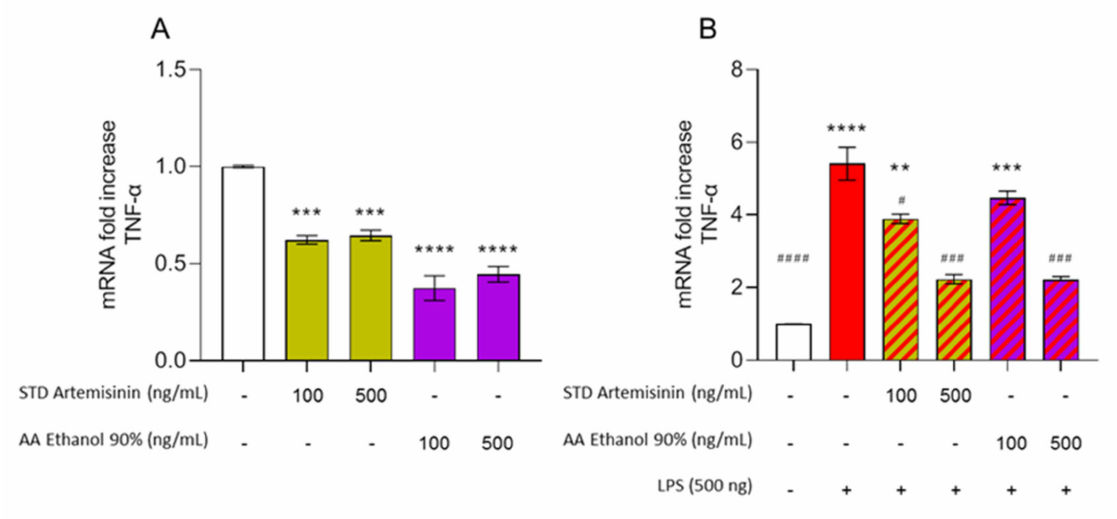
Figure 8. Ethanolic extracts of Artemisia annua and ART are able to act as a TNF- α inhibitor in the presence or absence of LPS. SH-SY5Y cells were treated for 24 h with STD Artemisinin and AA Ethanol 90% ( A ) or pre-treated for 2 h with the same treatments and then subjected to a LPS stimulus for 24 h ( B ). Cells were then processed in order to measure TNF- α m RNA levels by real-time PCR. GAPDH was used to normalize the results. Data are shown as mean ± SEM. Statistically significant differences are represented as follows: **** p ≤ 0.0001, *** p ≤ 0.001, and ** p ≤ 0.01 versus untreated cells and #### p < 0.0001, ### p ≤ 0.001, and # p ≤ 0.05 versus